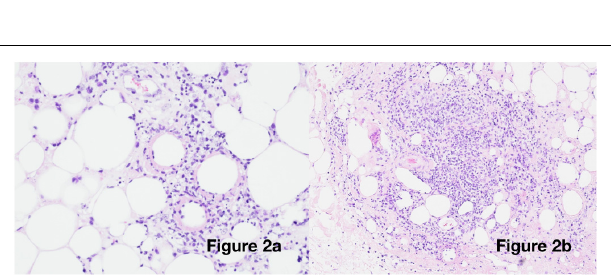
FIGURE 2 | Histological examination: Incisional biopsy from the right upper arm [haematoxylin and eosin (H&E) staining] showing (a) 20 × magnification: vasculitis and fibrinoid necrosis and (b) 10 × magnification: deep subcutaneous infiltrate with oedema and